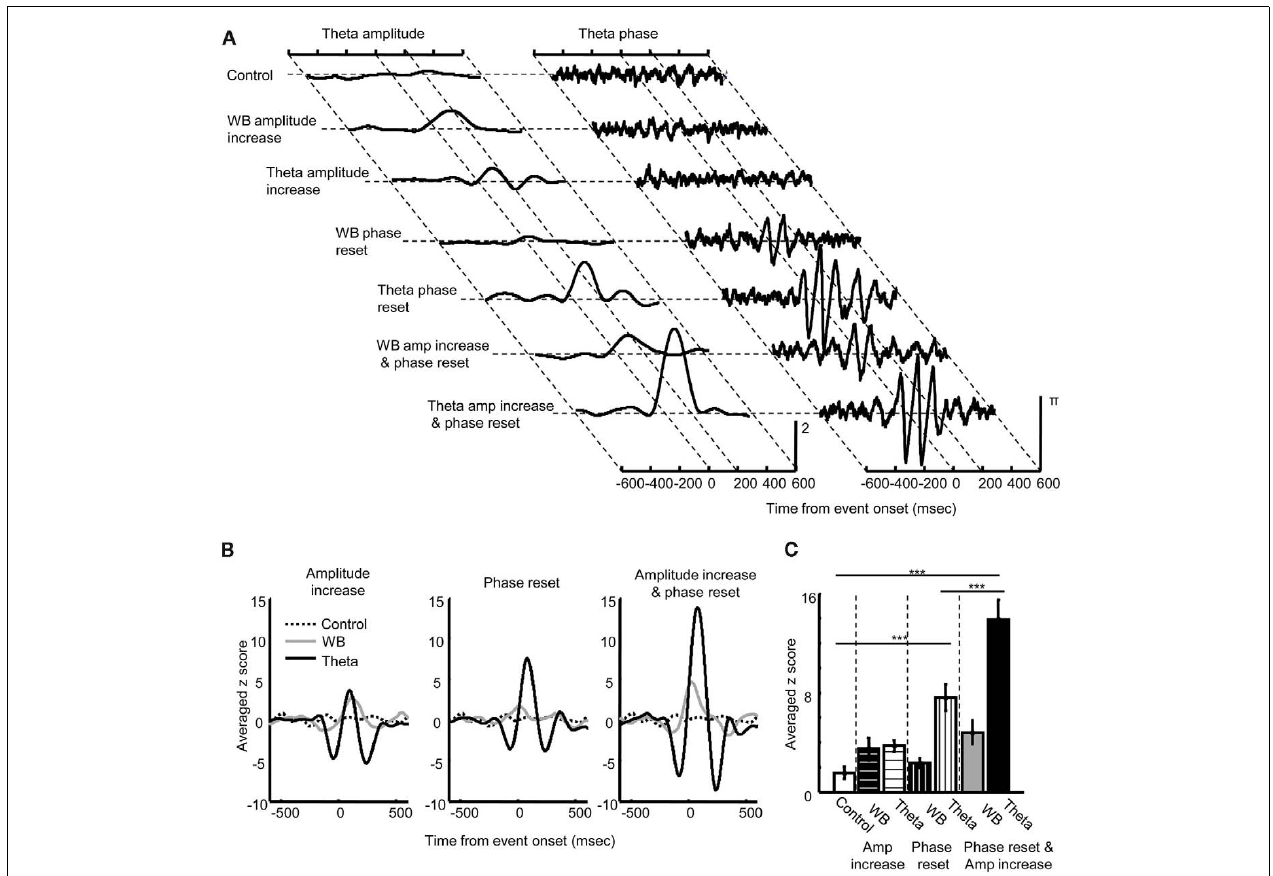
amplitude in the wide (gray) or theta band range (black) did not affect theta synchronization (left). In contrast, phase reset of theta oscillation (black), but not wide band oscillation (gray) induced theta synchronization (middle). Coincidence of phase reset and amplitude increase induced a large increase in theta synchronization (right, black). (C) The peak value of the normalized measure for theta synchronization (mean ± SEM from eight simulations) was compared across different types of manipulation.Theta phase reset alone (Theta in Phase reset) and the coincidence of theta phase reset and amplitude increase (Theta in Amp increase and phase reset) produced significantly stronger theta synchronization compared with a control without any manipulation of phase or amplitude (Control).The coincidence of theta phase reset and amplitude increase produced stronger theta synchronization than theta phase reset alone. ***Indicates p < 0.001 inTukey HSD